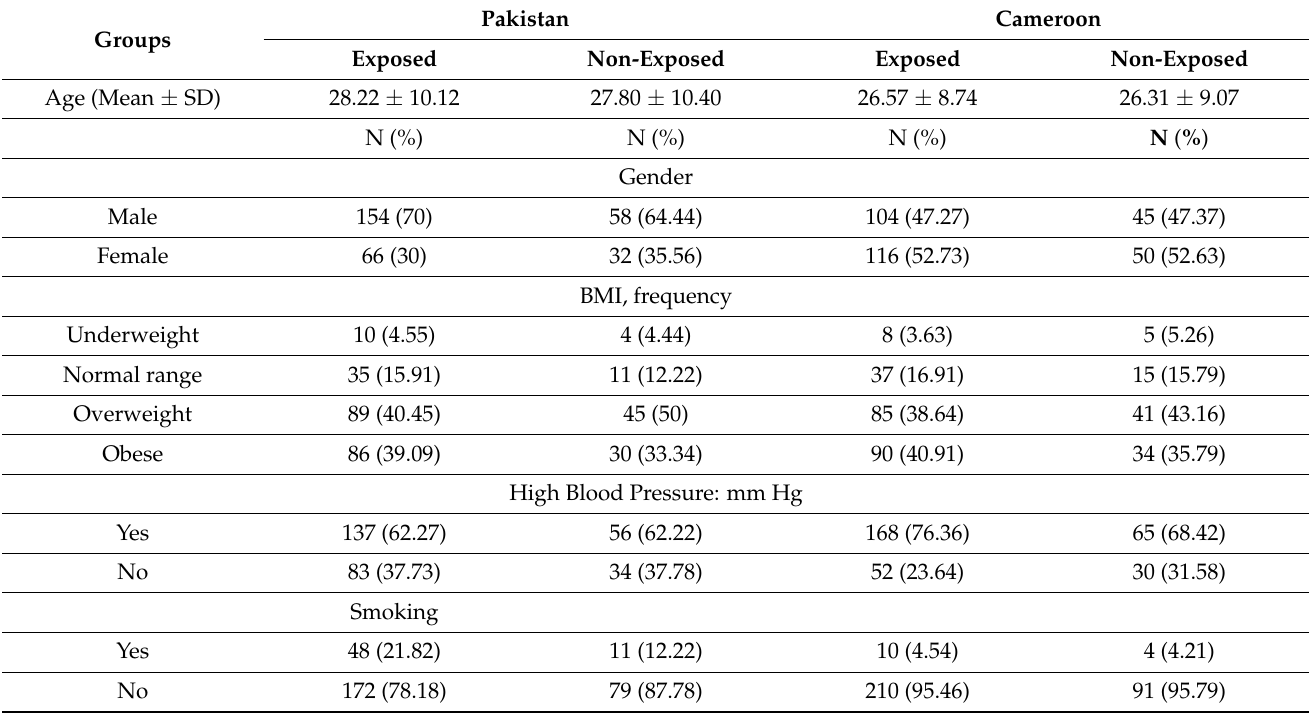
Table 1. Socio-demographic and Anthropometric data of our study population. Groups